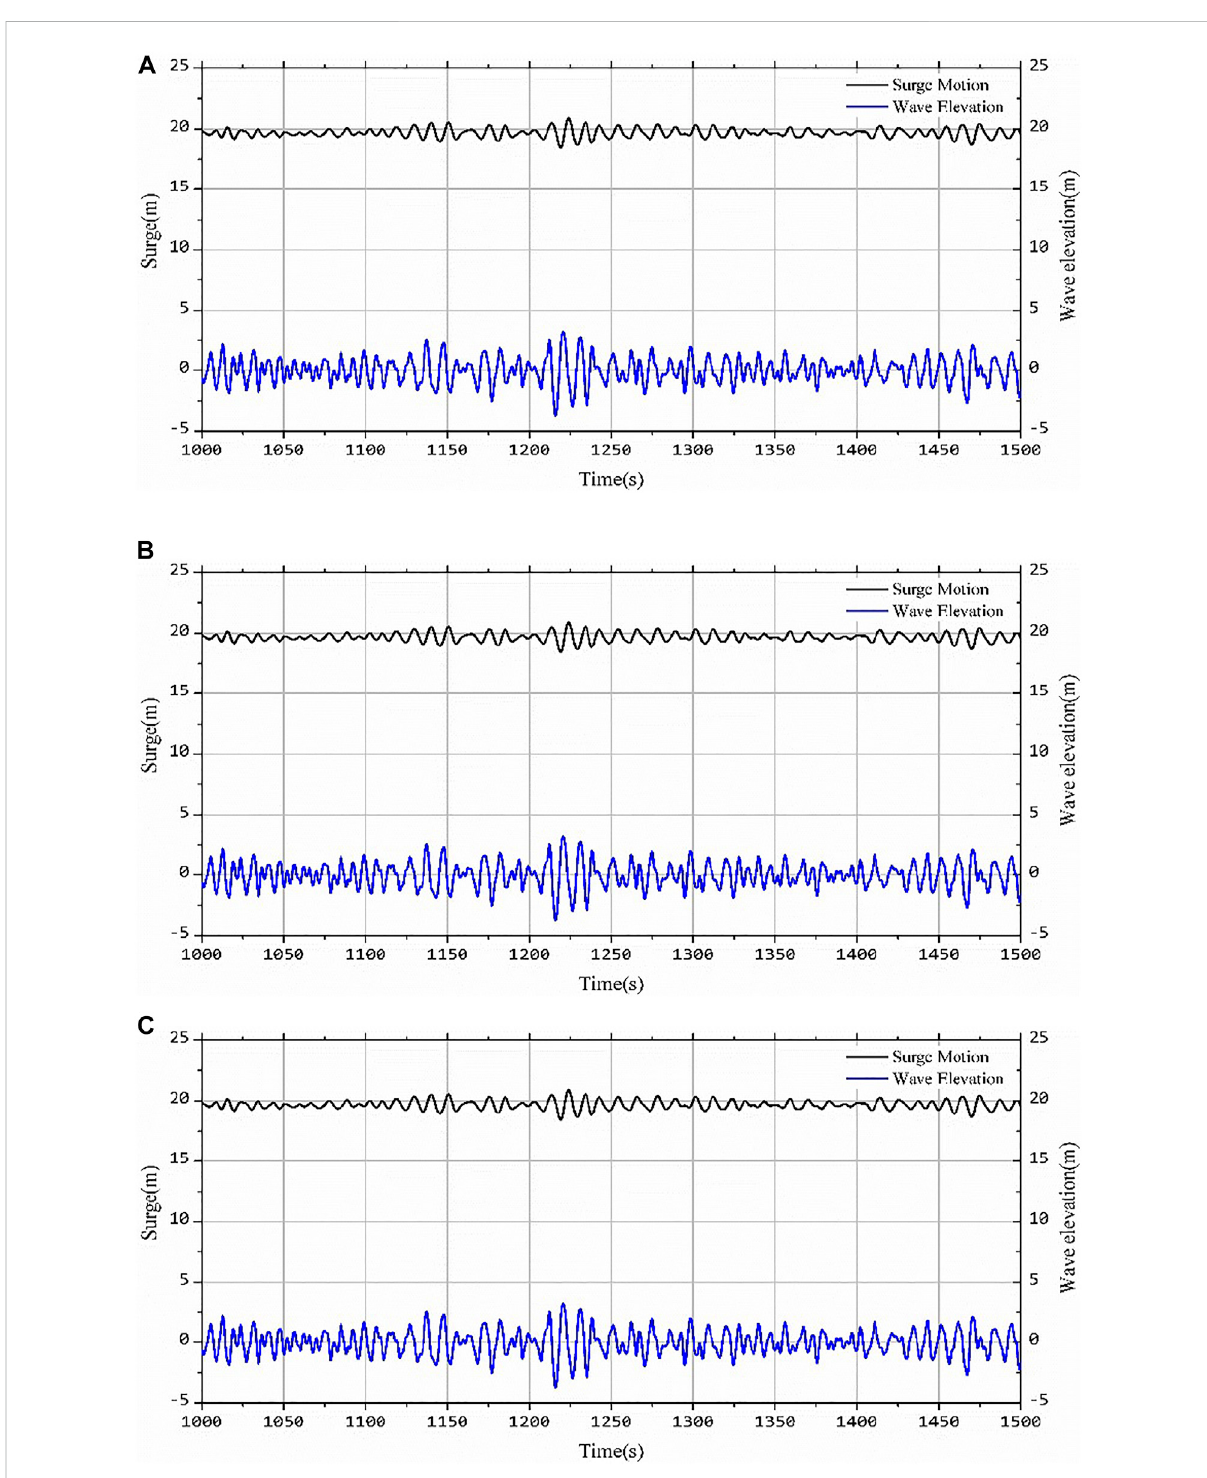
FIGURE 8 Motion response and wave height time history curve of fl oating fan under the irregular wave: (A) Surge; (B) Heave; (C)